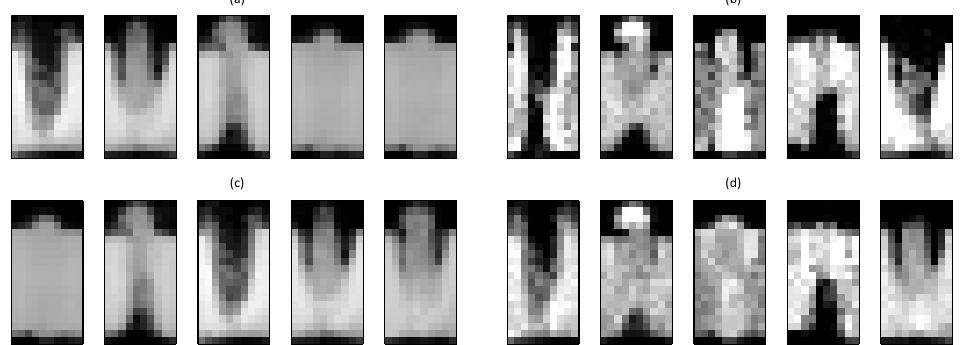
Figure 11. Alternative methods applied to the laser welding problem: ( a ) fuzzy c clustering, ( b ) LDA, ( c ) Principal Component Analysis (PCA) + fuzzy c methods and ( d ) ERT model topic definitions.